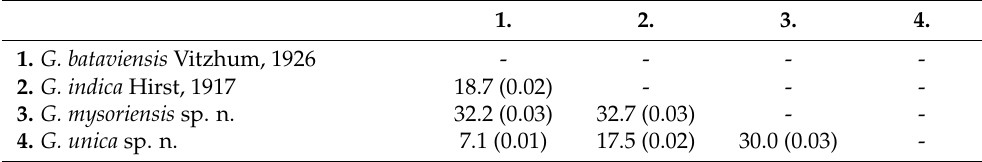
Table 4. Estimates of evolutionary divergences between COI sequences of Geckobia species.